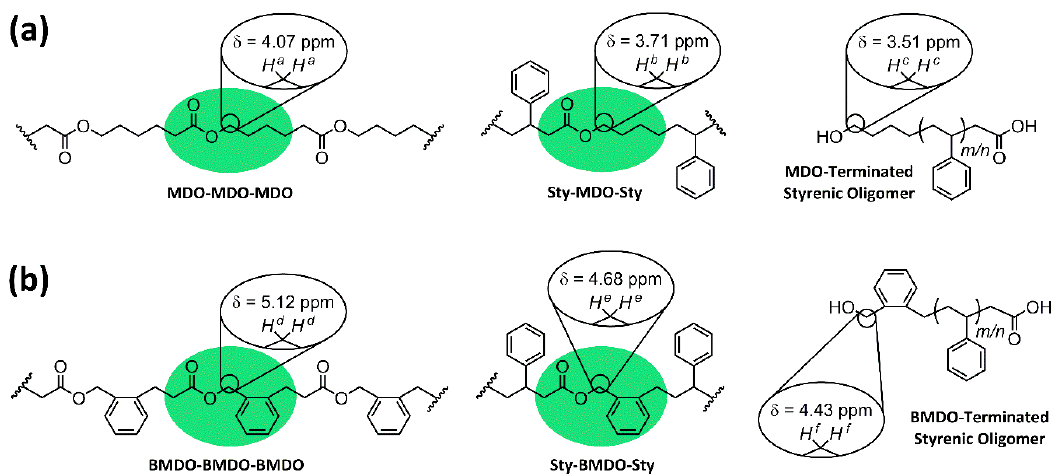
Figure 2. Illustration of key protons utilized for 1 H NMR (CDCl 3 ) characterization of poly(CKA- co